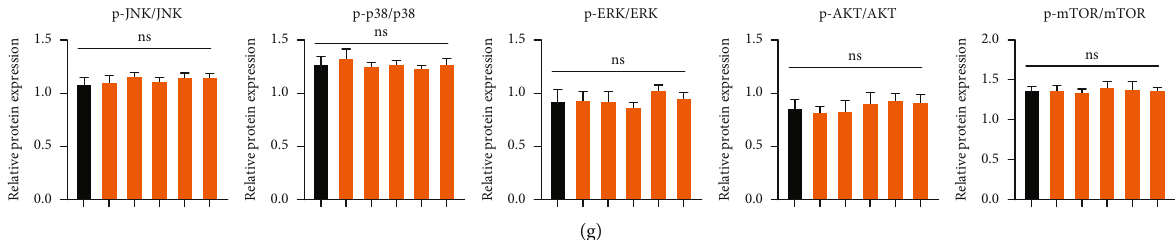
Figure 5: Vericiguat dually regulated RANKL-triggered activation of I κ B- α /NF- κ B signaling pathway. (a, b) Western blot results of the expression of osteoclast-related signaling pathways (NF- κ B, AKT, and MAPK) with or without RANKL stimulation ( n = 3 ). ∗ indicated a comparison with the control group without RANKL. (c, d) Western blot results of the expression of I κ B- α and NF- κ B in BMMs after treatment with RANKL (50 ng/ml) for 30 min followed by Vericiguat with indicated concentrations. (e) Immuno fl uorescence staining of RANKL-induced P65 nuclear translocation with or without Vericiguat with indicated concentrations. (f, g) Western Blot and quanti fi ed results of MAPK and AKT in BMMs after treatment with RANKL (50 ng/ml) for 30min followed by Vericiguat with indicated concentrations. n = 3 means three independent experiments. ∗ indicated a comparison with the control group (Vericiguat, 0nM): ∗ p < 0 : 05 , ∗∗ p < 0 : 01 , ∗∗∗ p < 0 : 001 , and ∗∗∗∗ p < 0 : 0001 . ns: not statistically signi fi cant. Scale bar = 100 μ m